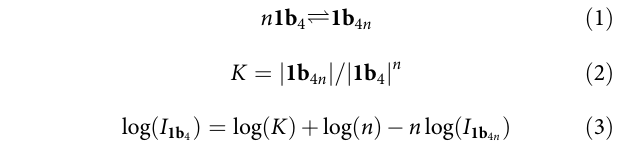
fractions 0.25 or 0.75 that correspond to the mixed tetramers of 1:3 and 3:1 composition; as well as lines with a maximum at 0.5 that correspond to the 2:2 stoichiometry. Lines with a more